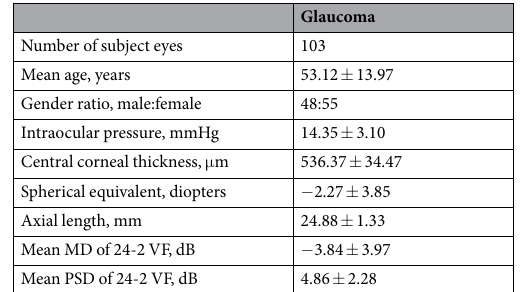
Table 1. Demographic and ocular characteristics of participants with glaucoma. Data are presented as the mean and standard deviation. MD = mean deviation; PSD = pattern standard deviation; VF = visual field.